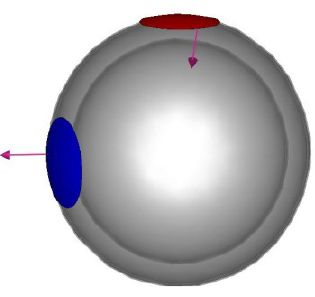
Fig. 2: The geometry of electrode and the current direction.